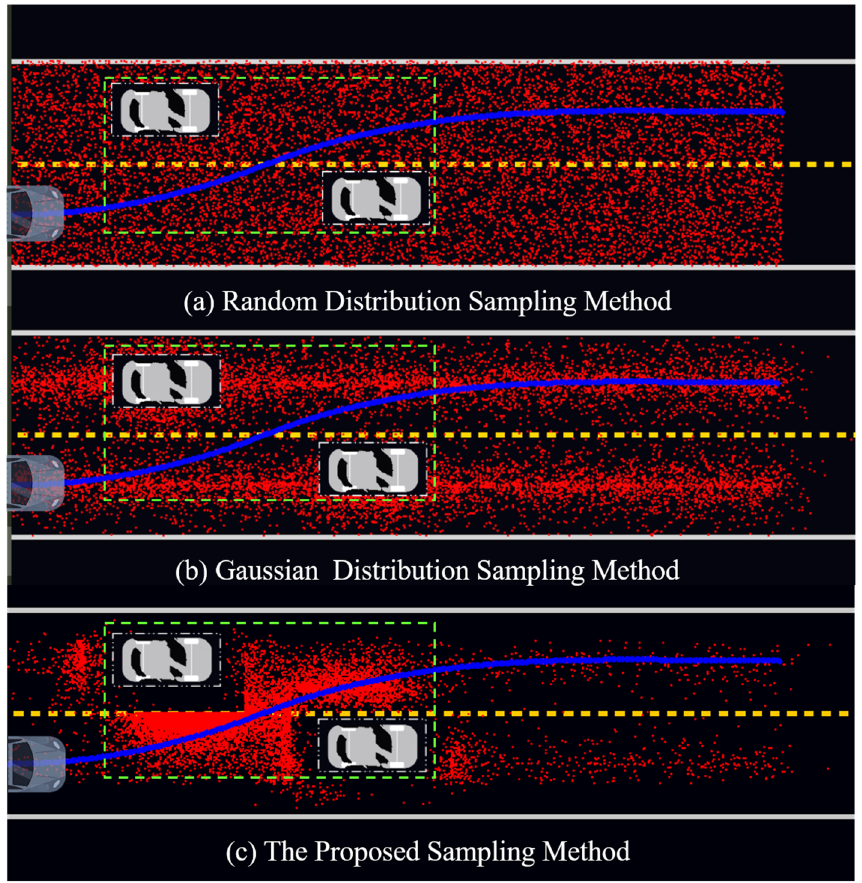
Figure 15. Results of the sampling experiment, where ( a ) is the result of the random distribution sampling method, ( b ) is the result of the Gaussian distribution sampling method and ( c ) is the result of the proposed sampling method.